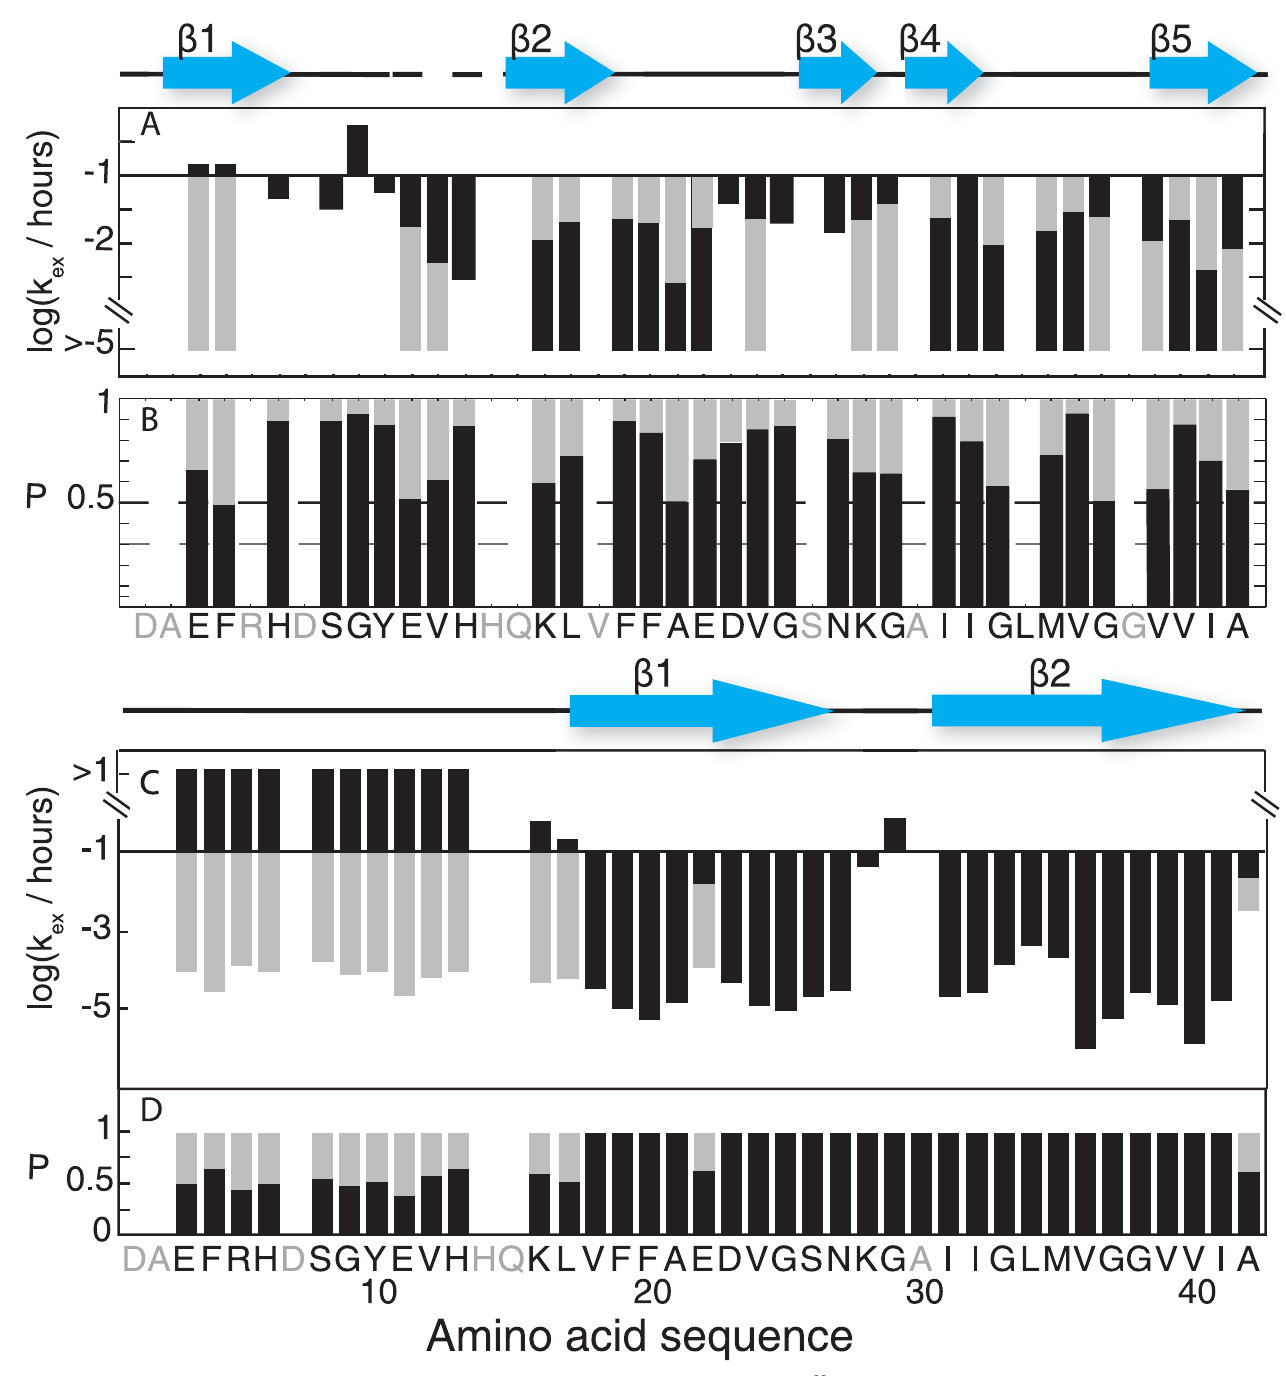
Fig 2. Structural differences of A β (1–42)fibrils of this study (A and B) and of A β (1–42) Mox fibrils of Lu¨hrs et al. (C and D) [16]. They are revealedby the amide exchangerates k ex / h -1 of individual 15 N- 1 H moieties and the relative population P (F) of the slow and fast exchanging componentsof the exchange.The exchangerates and populationP(F) of A β (1–42)fibrils of this study (A and B, coloredin grey and black) have been extracted from the H/D exchangecurves in Fig 1 and comparedwith correspondingvalues of the polymorphstudiedby Lu¨hrs et al. (C and D, colored in grey and black). The blue arrows are indicating the β -strands determined by solid-stateNMR of A β (1–42)fibrils and the one definedby Lu¨hrs et al. and the dashed line indicatesmissing data. Since the color code follows the main population,followingthe black colored data in Fig 1A elucidates immediately, that the main populationundergoesfast exchangebetweenresidues 1–13, slow exchangebetweenresidues 16–22,fast exchangebetween23–27 (with the exceptionof V24), slow exchangebetween28–36, fast exchangebetween37–39 (with no data for G38), slow exchangebetween40–41, and fast exchangefor residue 42.